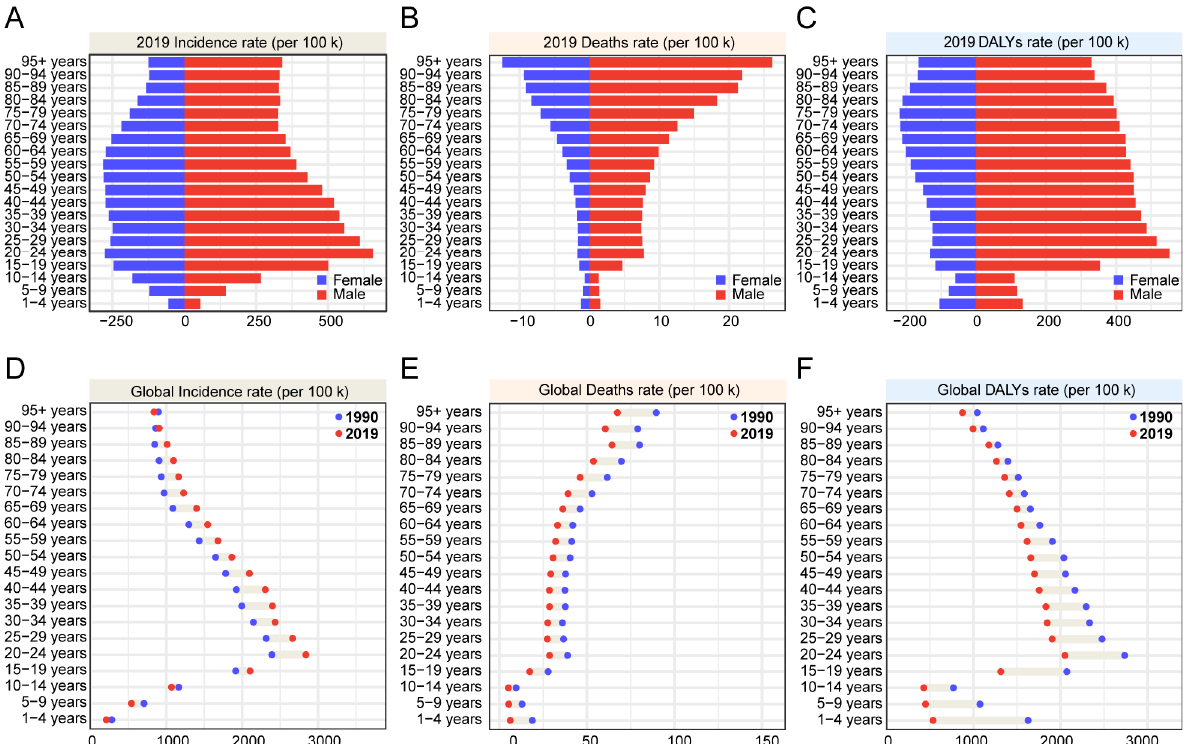
Figure 4. Incidence of RIs, deaths caused by RIs, and DALYs in different age groups. ( A – C ) The rates for various age groups in 2019 for both men and women; ( D – F ) the difference between 1990 and 2019 for the different age groups.